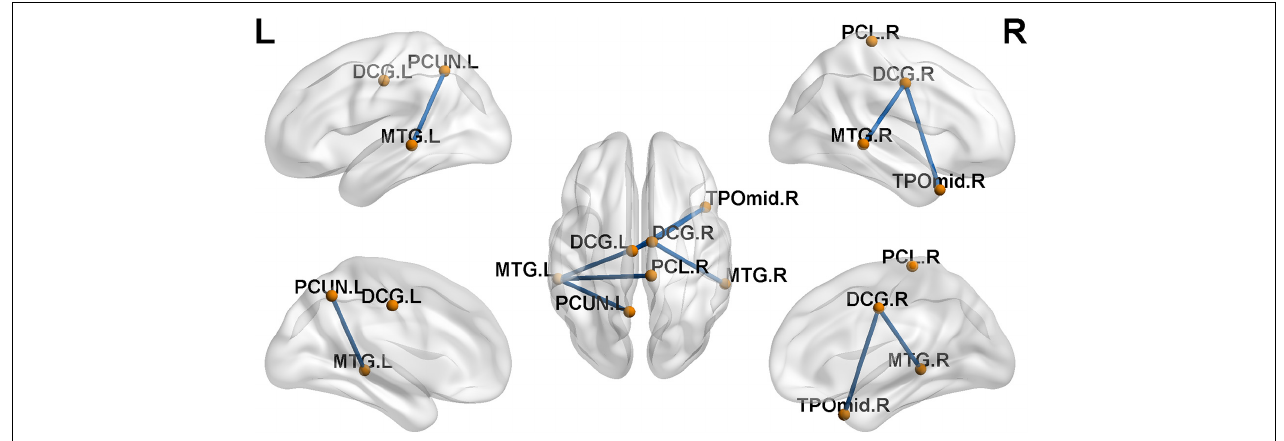
FIGURE 5 | Decreased functional connections in sensorineural hearing loss (SNHL) group when compared with the normal-hearing (NH) group ( p < 0.001, NBS corrected). The subnetwork is consisted with seven nodes and six